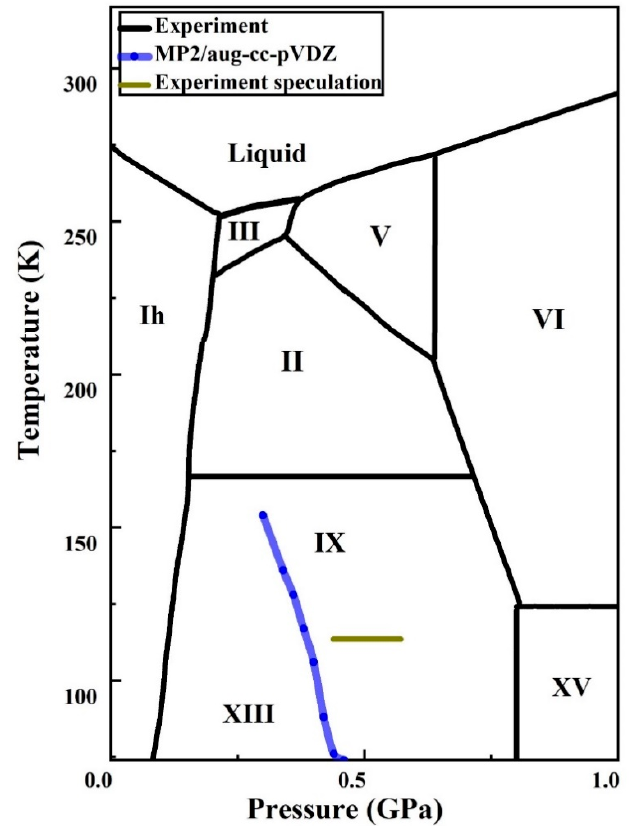
Figure 7. The phase diagram of ice. The black curves represent experimental data [7–9,29,39,54–59], while the blue and gray curves denote the calculated and speculated experimental [8,9,29] phase boundary between ice phase IX and phase XIII. The solid lines drawn here do not explicitly indicate regions of stability of all the ice phases. Several of these boundaries correspond to extrapolated equilibrium lines from experiments.